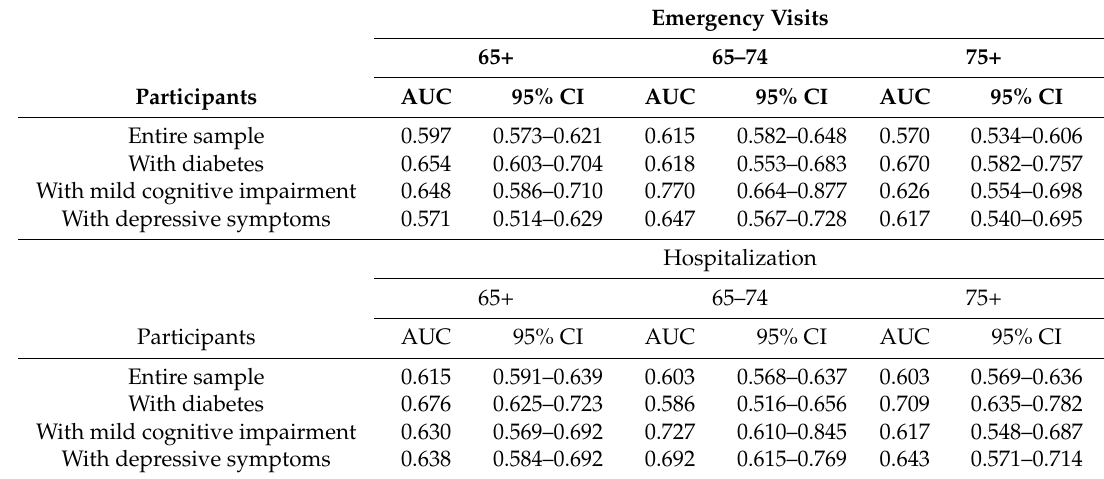
Table 3. Area under curve (AUC) for the combined effects of geriatric syndrome indicators on older adults’ emergency visits and hospitalization, by age group and baseline health